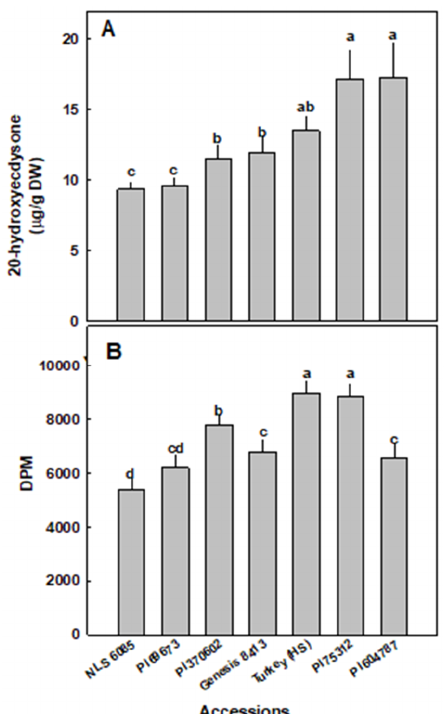
Figure 1. 20-Hydroxyecdysone content and anabolic activity in the leaves of 7 selected spinach accessions. ( A ) 20HE content was quantified using partially purified extracts of leaves from each of the 7 spinach accession analyzed via HPLC; ( B ) [3H] Leucine incorporation in L6 myotubes treated with different ecdysteroid-containing spinach extracts for 4 h was measured. Decays per minute (DPM) was normalized by total protein. The data represent the mean values ± standard error of the mean (SEM) of four replicates. Different letters above the means represent significant difference based on Tukey’s honestly significant difference (HSD) test at α = 0.05.